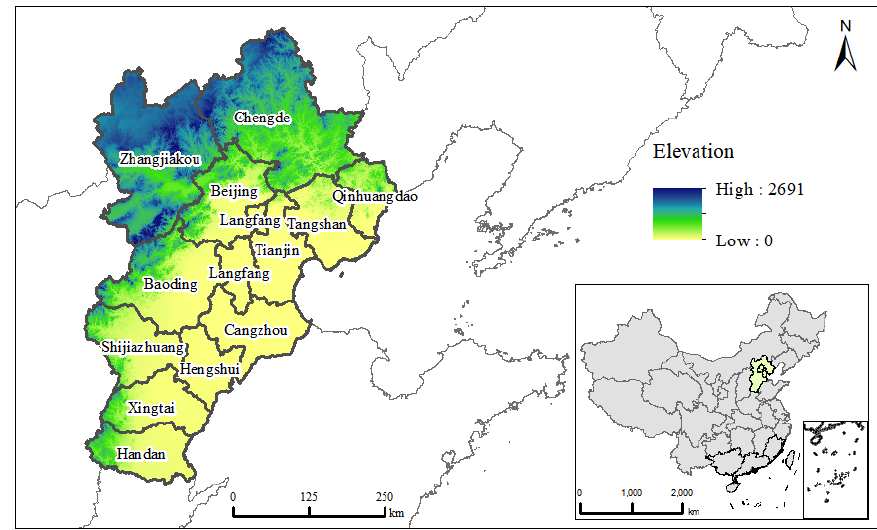
Figure 1. Location and range of Beijing–Tianjin–Hebei urban agglomeration.